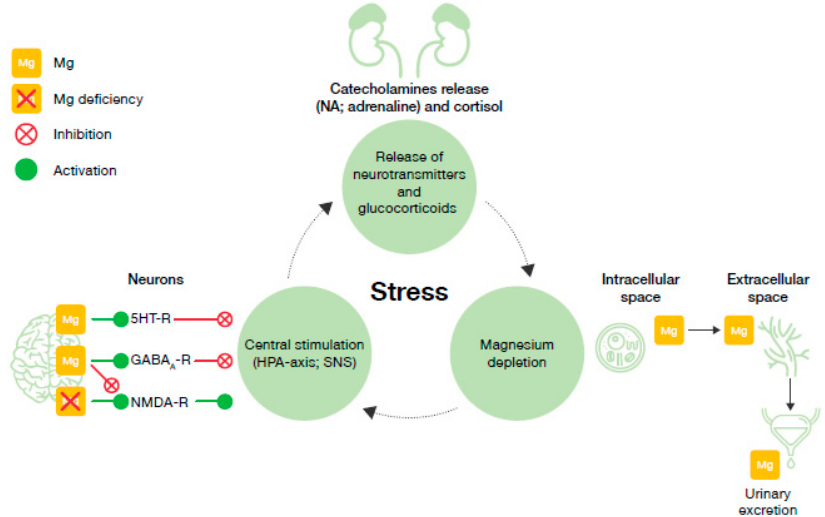
Figure 3. The vicious circle of stress and magnesium. GABAA-R, γ -aminobutyric acid-A receptor; Mg, magnesium; NMDA-R, N-methyl-D-aspartate receptor; NA, noradrenaline; SNS, sympathetic nervous system, 5HT-R, 5-hydroxytryptamine receptor.